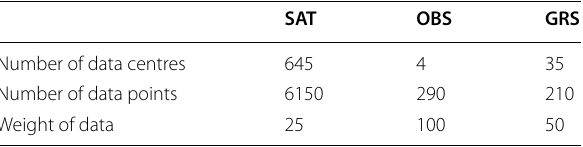
Table 2 The SACFM-2 model input data in three catego- ries, satellite (SAT), observatory (OBS) and geomagnetic repeat station (GRS) data